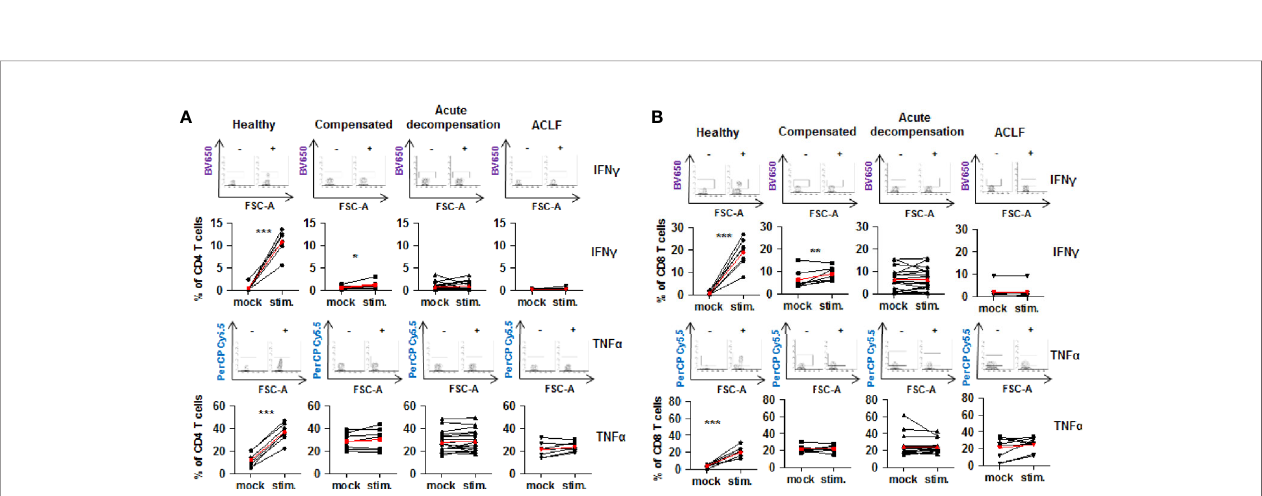
FIGURE 8 | Impaired on-demand production of pro-in fl ammatory cytokines in CD4+ and CD8+ T cells of patients with liver cirrhosis. CD4+ T cells (A) and CD8+ T cells (B) from healthy controls are patients with compensated/stable decompensated liver cirrhosis, acute decompensation of liver cirrhosis, or ACLF were stimulated ex vivo with PMA/Ionomycin for 6 h. Production of IFN- g and TNF- a at baseline before stimulation and after stimulation were assessed by fl ow cytometry. Typical examples of dotplots of fl ow cytometric analysis of healthy controls or patients with compensated liver cirrhosis, decompensated liver cirrhosis or ACLF are shown in the upper panels whereas mean values and standard deviations are shown in graphs in lower panels. Red bars indicate mean increase of pro-in fl ammatory cytokine production from baseline to 6 h after stimulation. * P <0.05, ** P <0.01, *** P